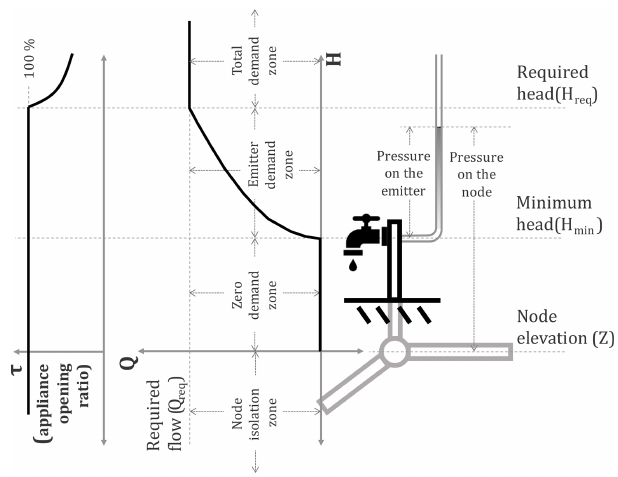
Figure 1. Interpretation of the nodal demand vs. head curve.